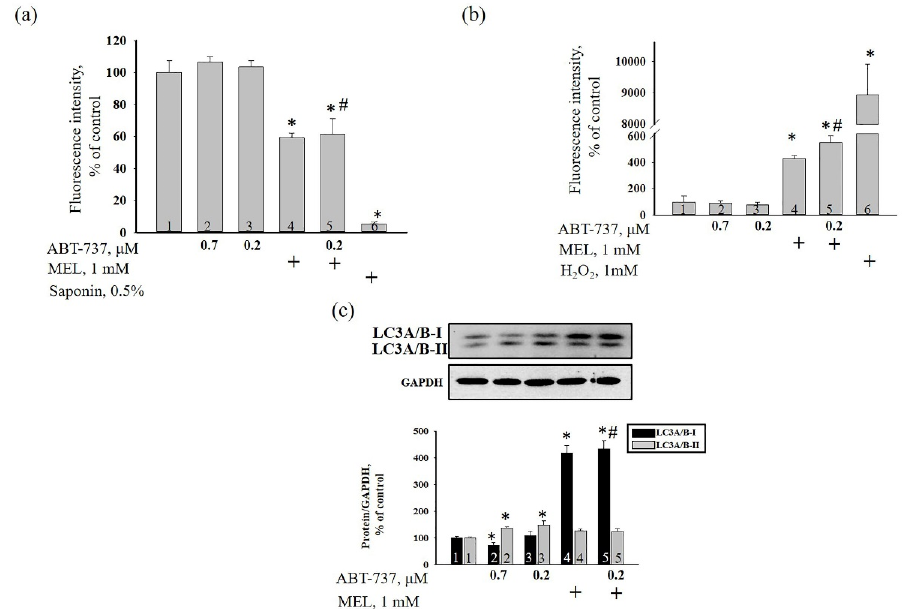
Figure 4. The e ff ect of MEL and ABT-737 on the membrane potential ( ∆Ψ m ) ( a ), ROS production ( b ) Figure 4. The effect of MEL and ABT-737 on the membrane potential ( ΔΨ m ) ( a ), ROS production ( b ) and in the level of autophagy marker LC3A/B ( c ) in HL-60 cells. Cells were treated with 0.7 μ M ABT- and in the level of autophagy marker LC3A / B ( c ) in HL-60 cells. Cells were treated with 0.7 µ M ABT-737 (column 2), and 0.2 µ M ABT-737 (columns 3) and 1 mM MEL (column 4), and MEL in combination with 0.2 µ M ABT-737 (column 5); untreated cells (control, column 1). ( a ) the alteration of ∆Ψ m in our experimental conditions. Saponin (0.5%) was used as a positive control; ( b ) the alteration of ROS production in our experimental conditions. H 2 O 2 (1 mM) was used as a positive control; ( c ) western blot of autophagy marker LC3A / B. The ratio of protein levels to GAPDH was used as a loading control. The protein level in the cell lysate without any additives served as a control (100%). “ + ” means the presence of MEL, Saponin and H 2 O 2 , respectively. The data are presented as the means ± S.D. of five separate experiments. * p < 0.05 significant di ff erence in values compared with the corresponding control (untreated cells), # p < 0.05 significant di ff erence in values relative to ABT-737 alone (0.2 µ M, column